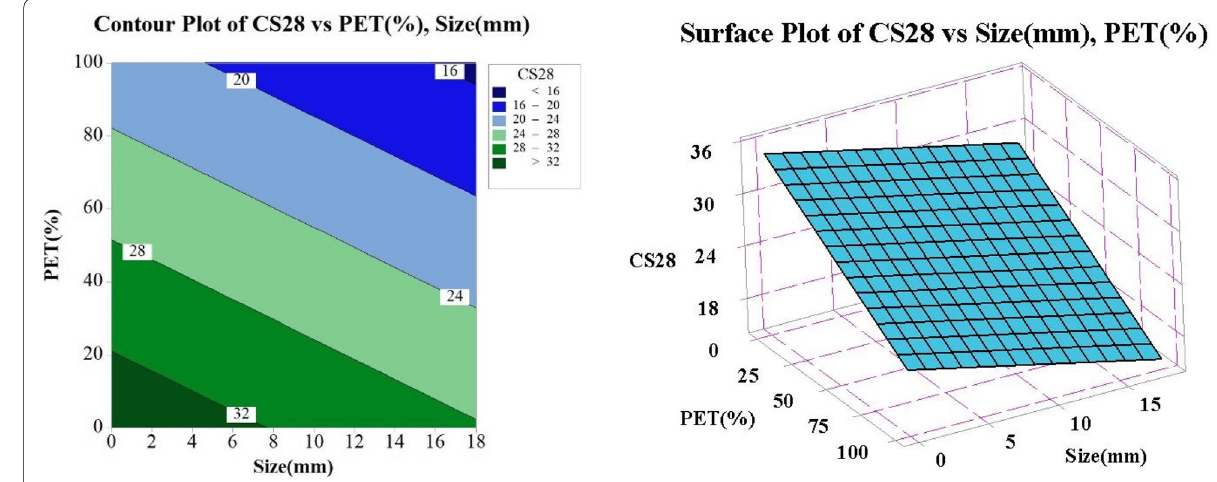
Fig. 4 Residual versus Order Plot of PET-CA expression